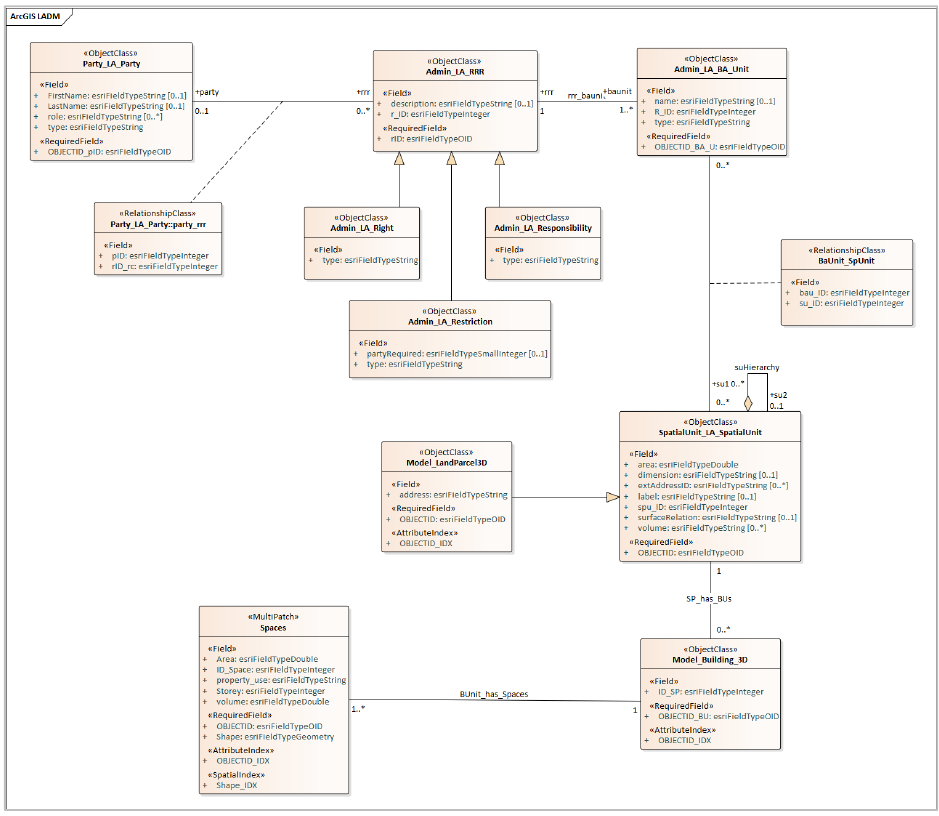
Figure 1. Conceptual schema of the developed data